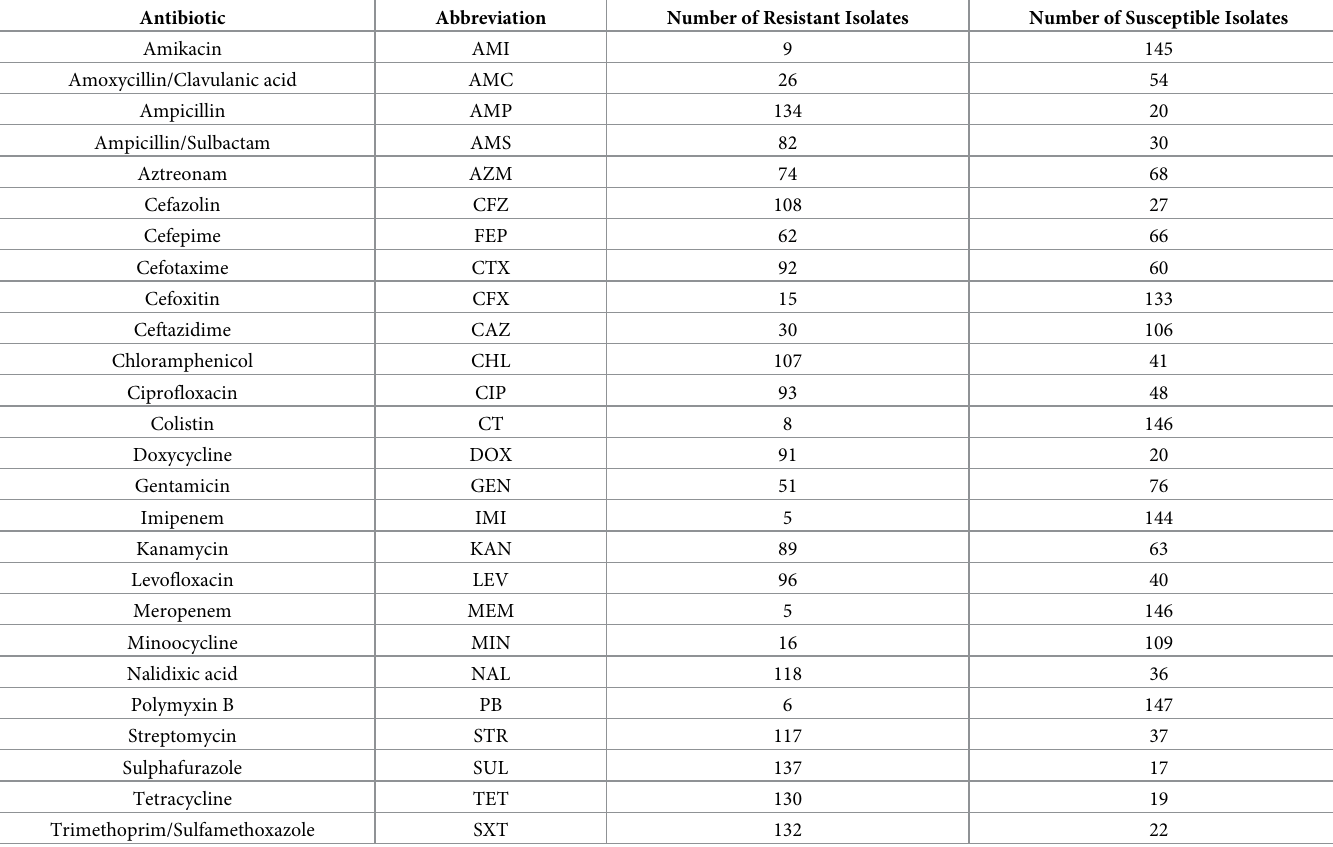
Table 1. Number of resistant and susceptible isolates included in this study. Antibiotic Abbreviation Number of Resistant Isolates Number of Susceptible Isolates